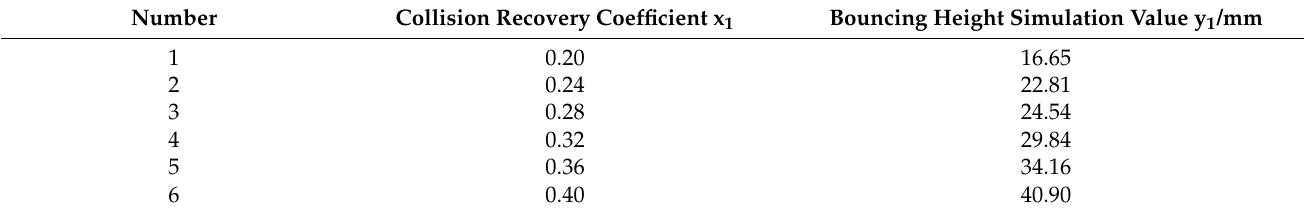
Table 3. Experimental scheme and results of restitution coefficient simulation experiment.